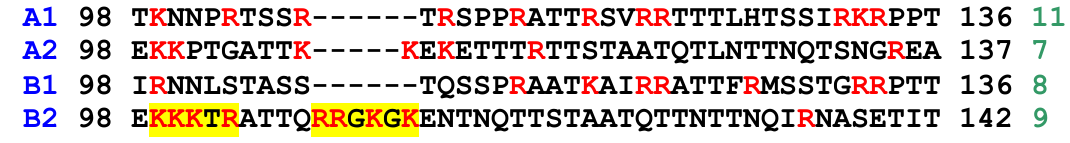
Figure 3. Comparison of the predicted amino acid sequence for representatives of each strain of hMPV G protein (residues 98–136/137/142 of the extracellular domain). Strains are shown in blue and number of positively charged residues (shown in red in the sequence) is indicated in green at the end of each sequence. The yellow highlights in the B2 sequence indicate the previously identified heparin binding domains